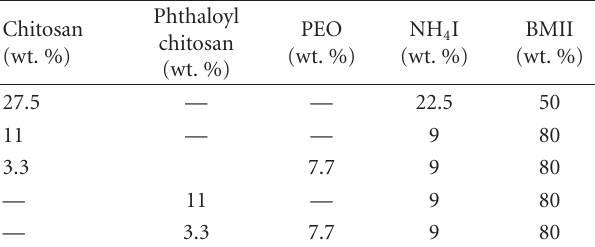
Table 1: Various electrolyte